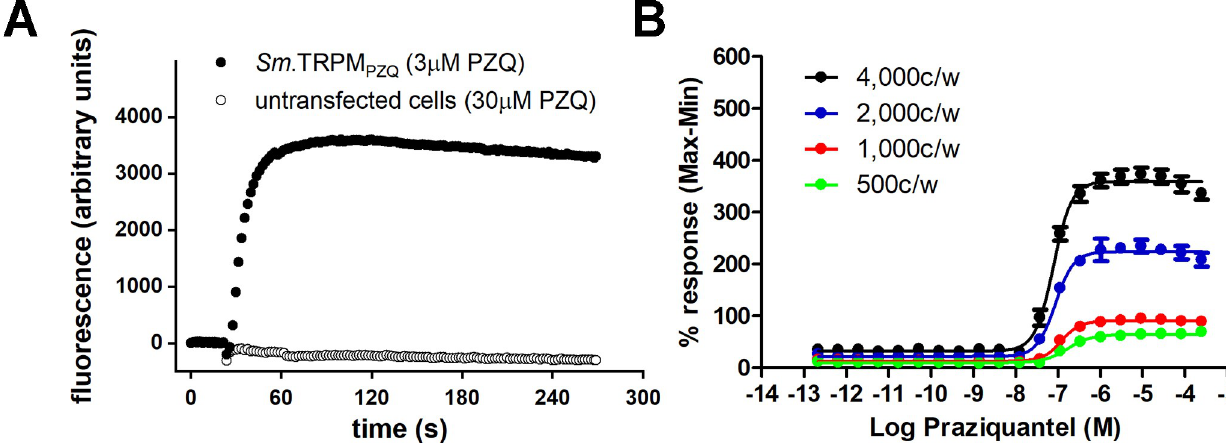
Fig 1. Optimization of assay conditions for monitoring Sm .TRPM PZQ activity. ( A ) Representative fluorescence trace showing the kinetics of the Ca 2+ signal resulting from addition of PZQ (3 μ M) to HEK293 cells transiently expressing Sm .TRPM PZQ (closed symbols), or addition of a higher concentration of PZQ (30 μ M) to untransfected HEK293 cells (open symbols). ( B ) Concentration response curves of PZQ-stimulated Ca 2+ signals in Sm .TRPM PZQ expressing HEK293 cells resolved at various densities of cells per well (c/w) measured in suspension in 1,536 well plates at room temperature. Each point on each curve represents the average of responses from 16 replicates which were also run in 2 separate experiments to achieve average and standard deviation.